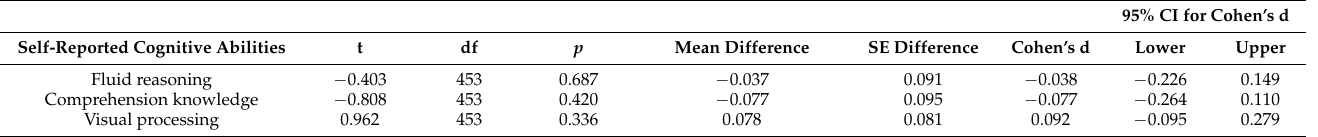
95% CI for Cohen’s d